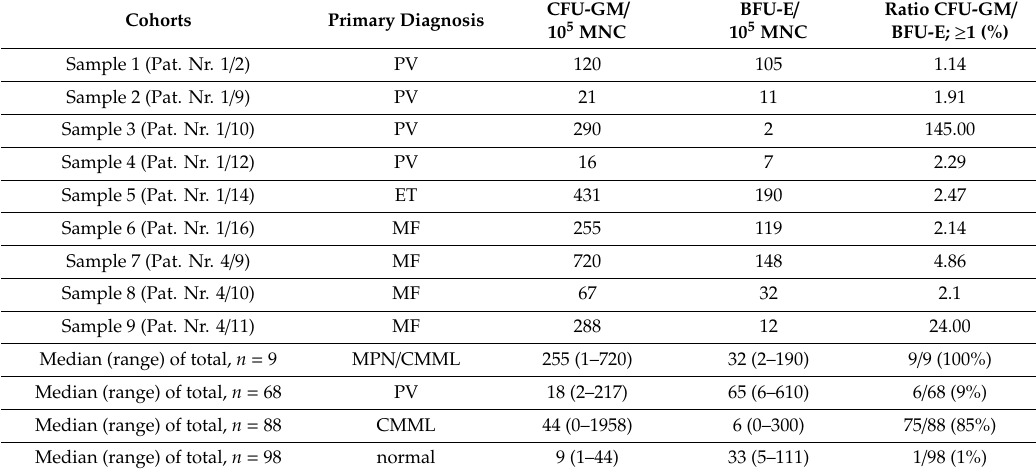
Table 2. In Vitro Myelomonocytic Skewing in Myeloid